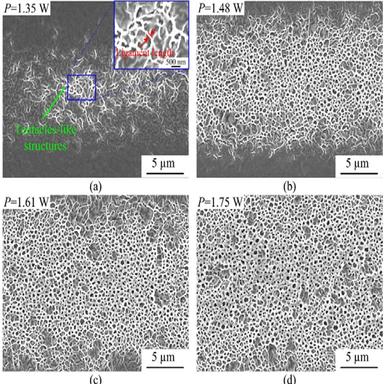
SEM morphologies of the single-line scanned regions obtained under various laser powers (v = 10 mm/s, f = 700 kHz): (a) 1.35 W, (b) 1.48 W, (c) 1.61 W, and (d) 1.75 W.